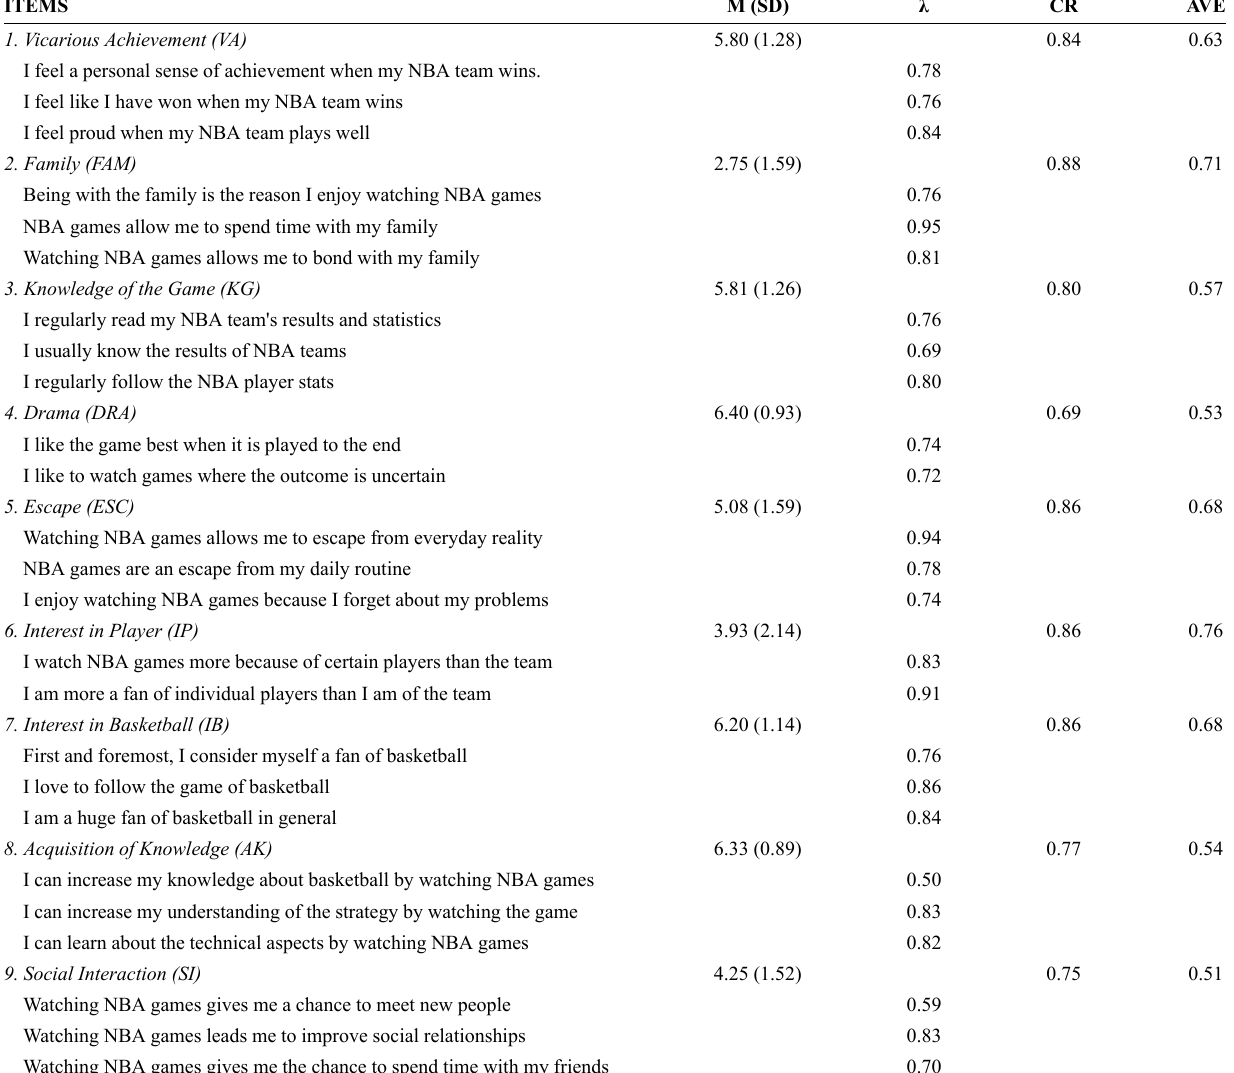
Table 3 - Factor loadings, composite reliability, convergent validity, and dimension means. ITEMS